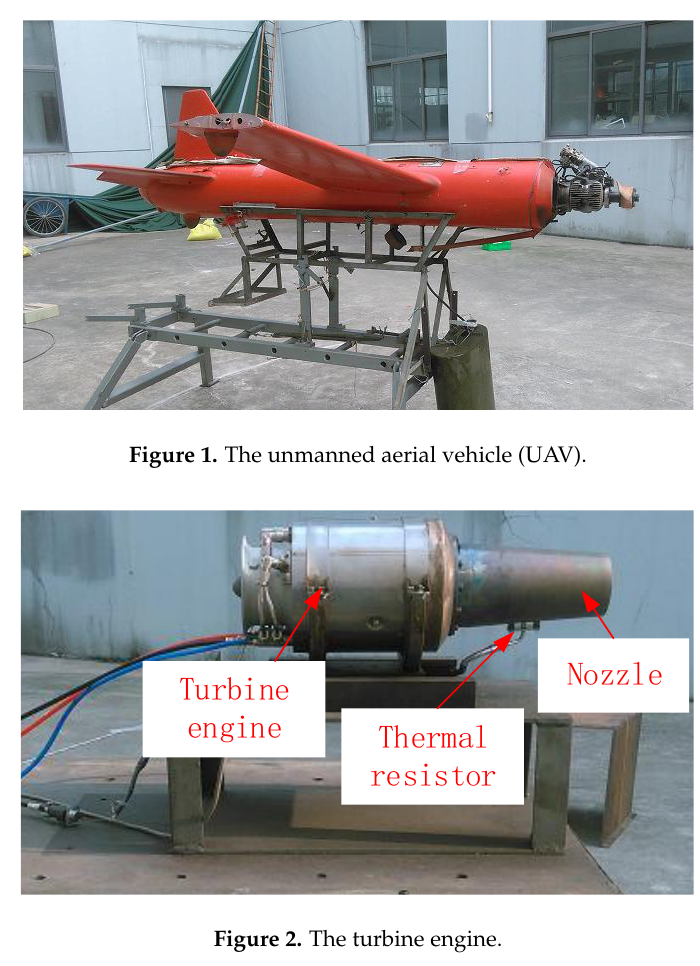
Figure 2. The turbine engine.